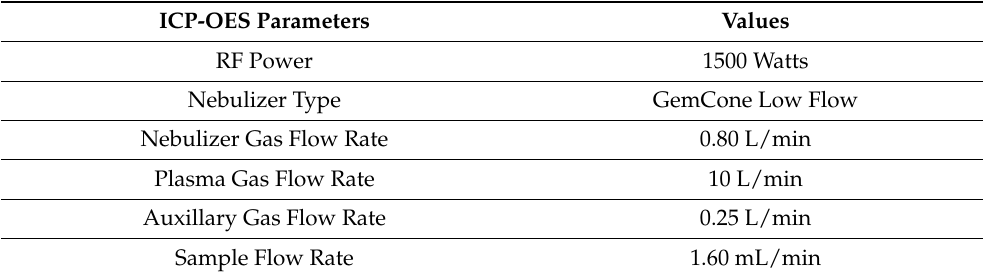
Table 2. Parameters for the elemental analysis by ICP.